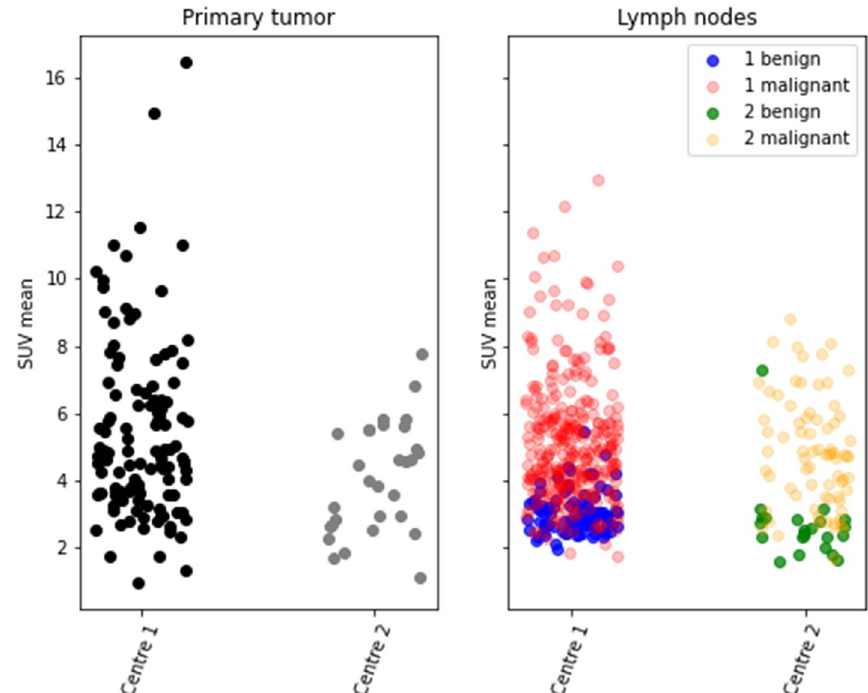
distribution of SUV-mean of benign and malignant lymph nodes